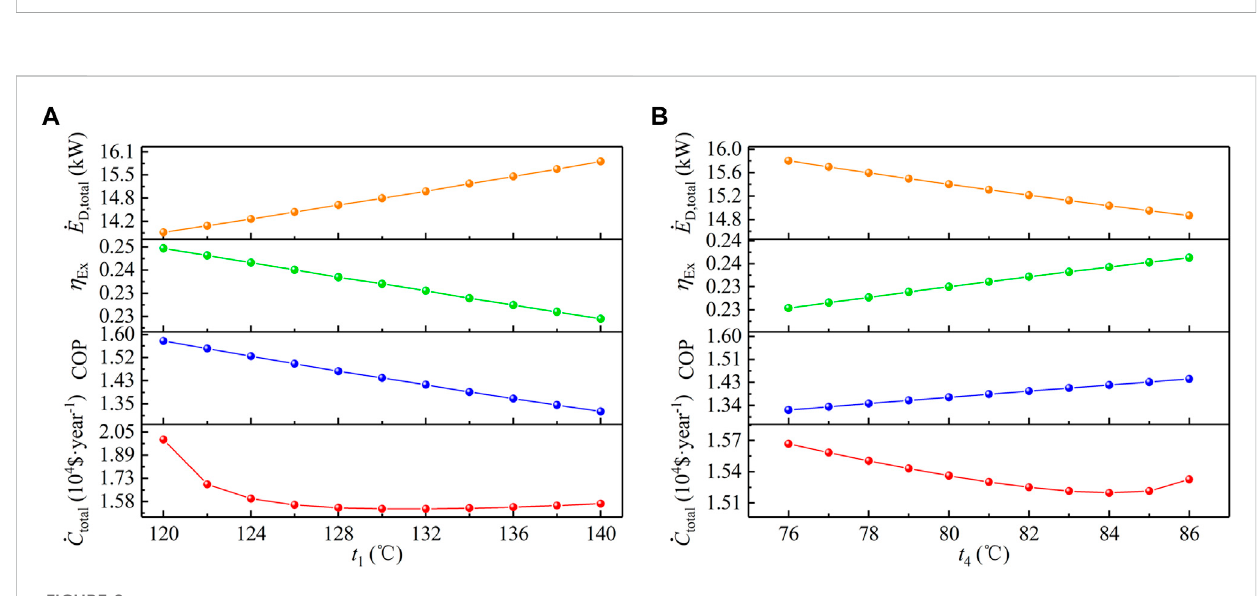
FIGURE 7 Variations of annual total cost under different thermal parameters.